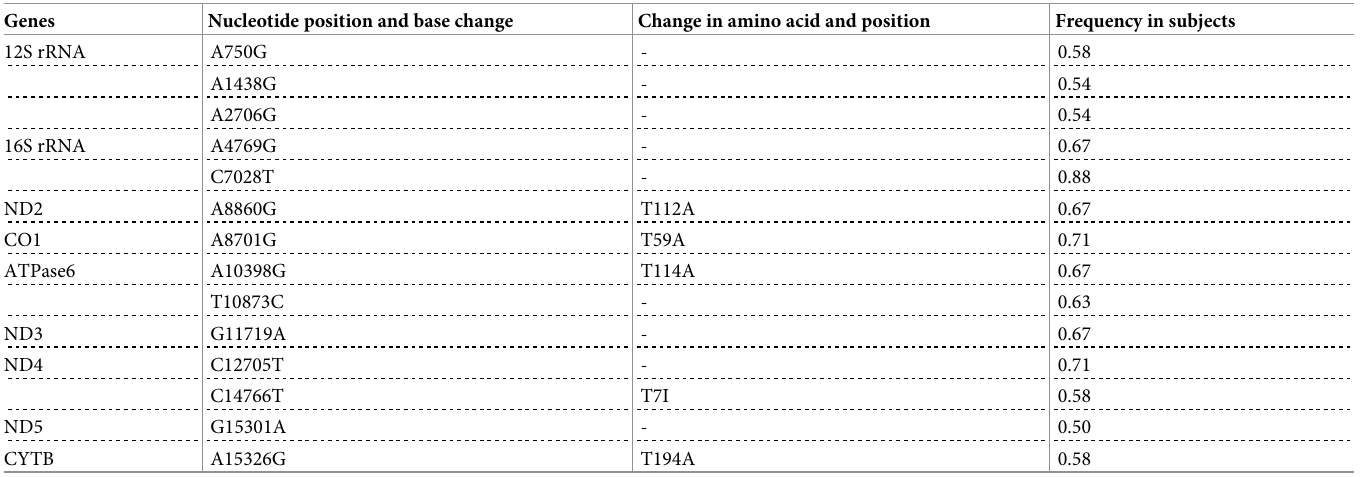
12S rRNA = Small ribosomal RNA of the mtDNA; 16S rRNA = Large ribosomal RNA of the mtDNA; ND2, ND3, ND4 and ND5 = subunits 2, 3, 4 and 5 of NADH dehydrogenase; CO1 and CO3 = cytochrome oxidase subunits 1 and 3; ATPase6 = subunit 6 of mitochondrial ATPase; CYTB = Cytochrome b. Frequency in subjects = number of subjects showing the nucleotide variant (n)/total number of subjects whose mtDNA were sequenced